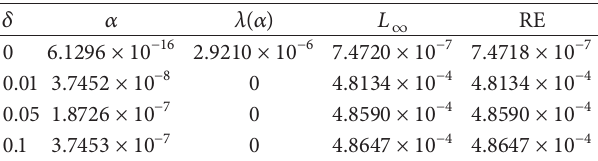
Table 4: 𝑇 = 1.2 , the objective function 𝜆(𝛼) , the 𝐿 ∞ , and the relative errors for 𝑓(𝑥) , with 𝛿 = 0,0.01, 0.05, 0.1